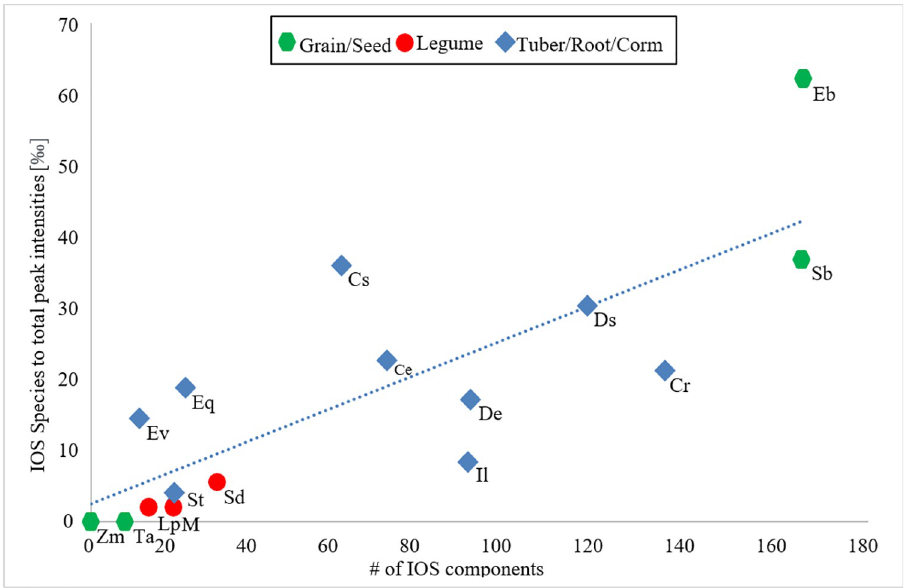
Fig 7. Total number of ‘Island of Stability’ (IOS) species compared to their relative total peak intensity. Number of IOS components estimates the amount of recalcitrant Maillard reaction products formed in starch–glycine